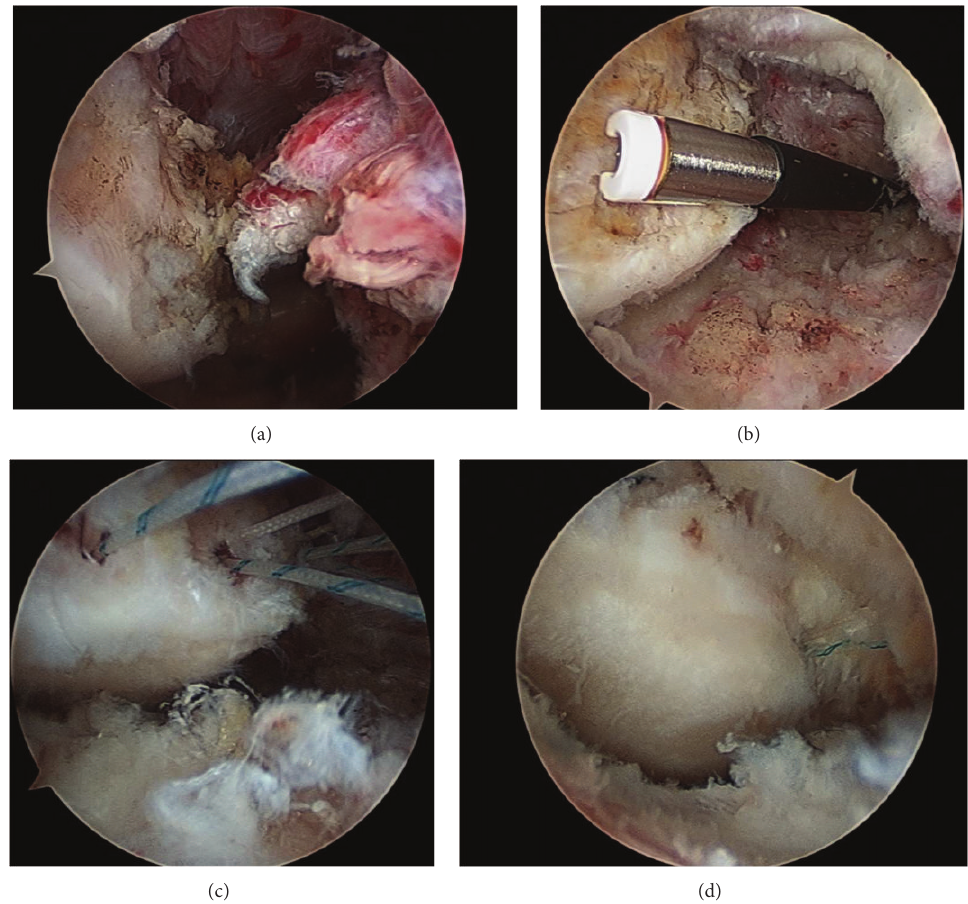
Figure 6: Intraoperative arthroscopic findings. (a) Arthroscopic images from the lateral suprapatellar portal. Left, patella; right, ruptured tendon. (b) Arthroscopic view from the lateral suprapatellar portal. A high-frequency radiofrequency device was inserted via the medial suprapatellar portal to debride synovia and ruptured fibers. (c) Arthroscopic view from the lateral suprapatellar portal. A suture anchor was inserted at the medial upper rim of the patella. Two bone tunnels were created at the central and lateral upper rim of the patella and two strands of #2 Ultrabraid sutures were inserted into each bone tunnel. (d) Arthroscopic view from the lateral suprapatellar portal after the repair. Continuity of the patella and the quadriceps tendon was